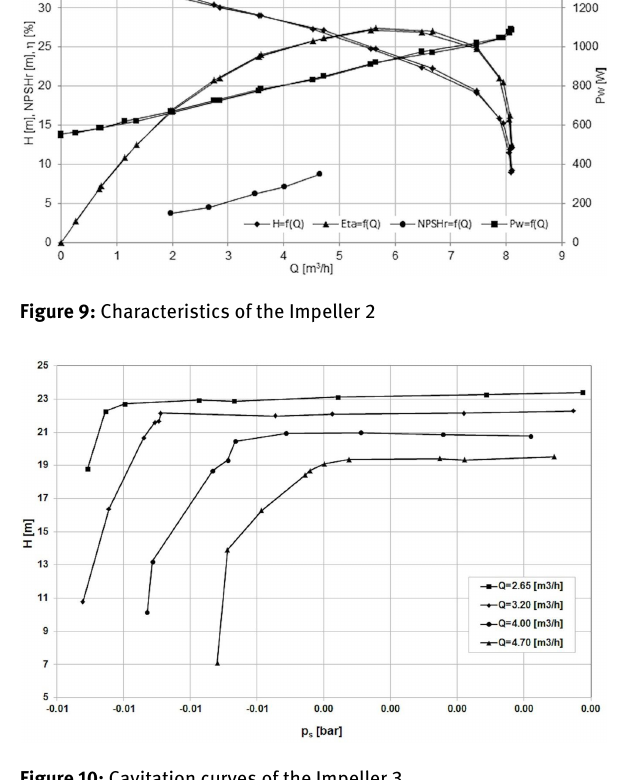
Figure 10: Cavitation curves of the Impeller 3